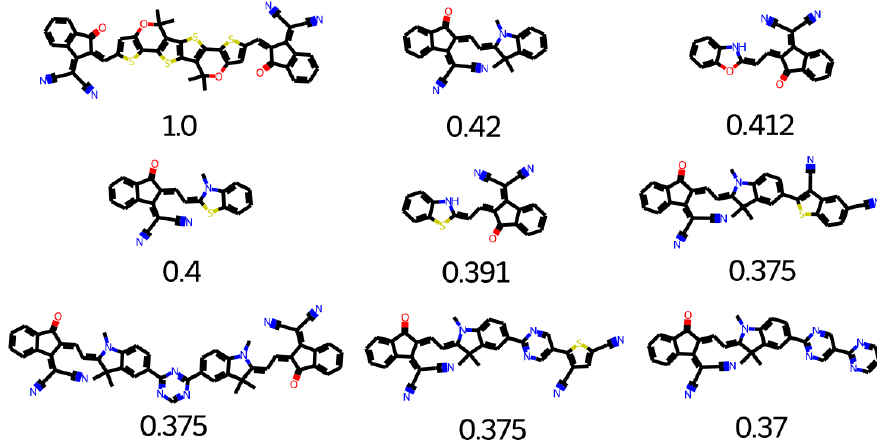
Figure 16. Scatter plot between experimental and predicted LUMO using Hist gradient booting.